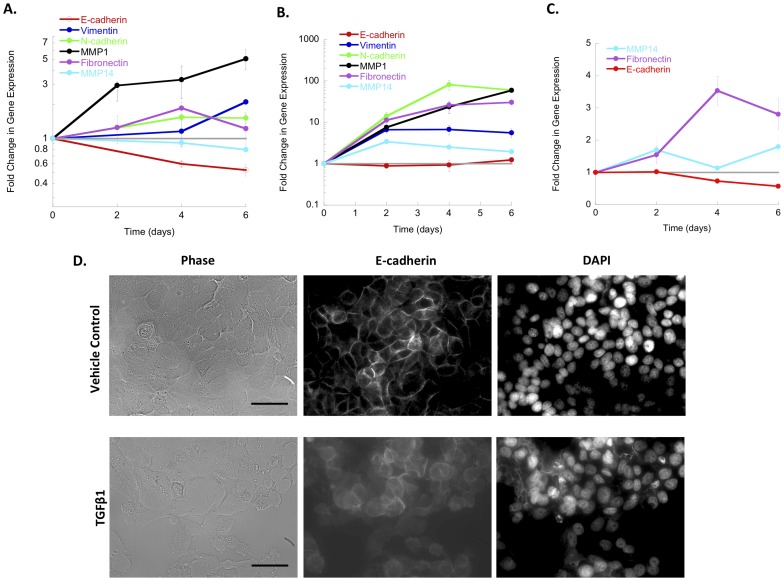
Gene expression changes under array conditions define a time course for studying transcriptional changes in EMT.Gene expression changes in treated cells are shown normalized to levels in vehicle controls (dashed grey line). All differences had reached significance by the end of the six-day time period except for E-cadherin in TGF-β1 treated HMLE Twist ER. A. Changes in E-cadherin and mesenchymal marker expression in HMLE Twist ER cells treated with 4OHT. B. Changes in E-cadherin and mesenchymal marker expression in HMLE Twist ER cells treated with TGF-β1. C. Changes in E-cadherin and mesenchymal marker expression in MCF-7 cells treated with TGF-β1. D. Decreased E-cadherin protein localization at the cell membrane in HMLE Twist ER cells treated with TGF-β1. Scale bar, 100 μm. Error bars indicate standard error of the mean.